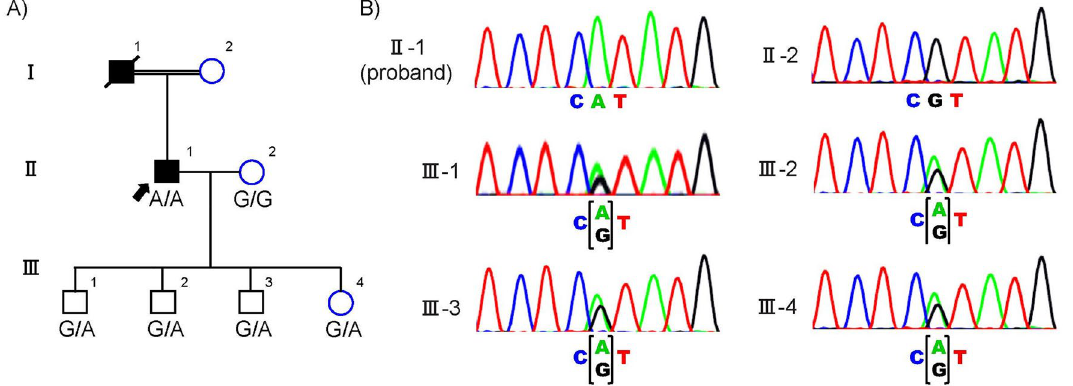
Figure 1. Genetic analysis of the consanguineous family with retinitis pigmentosa. ( A ) Family pedigree with variant in CNGA1. Circles represent females and squares represent males. Black filled squares represent patients with RP. Proband is indicated by black arrow. ( B ) Electropherograms around codon 280 in the CNGA1 gene in the peripheral blood DNA. The result of the proband showed c.839G > A in homozygosity (II-1). The result of his partner showed wild (II-2). The result of the other unaffected members showed c.839G > A in heterozygosity.